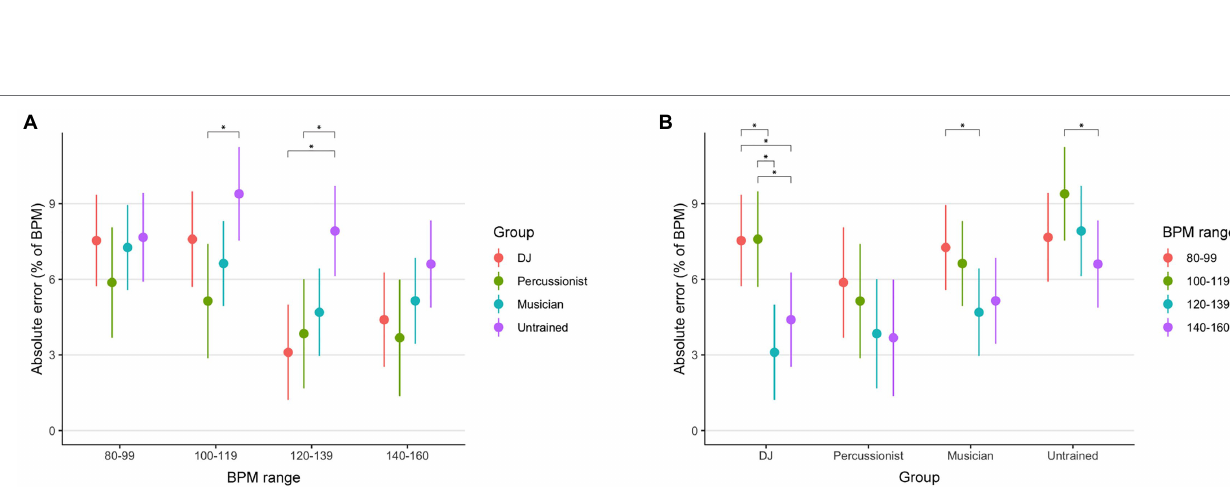
FIGURE 1 | Distribution of tempos reported as typically played by participants in the DJ group. Each participant reported a range of tempos (minimum and maximum), and the distribution shows at each BPM what proportion of DJ participants included this tempo in their range.